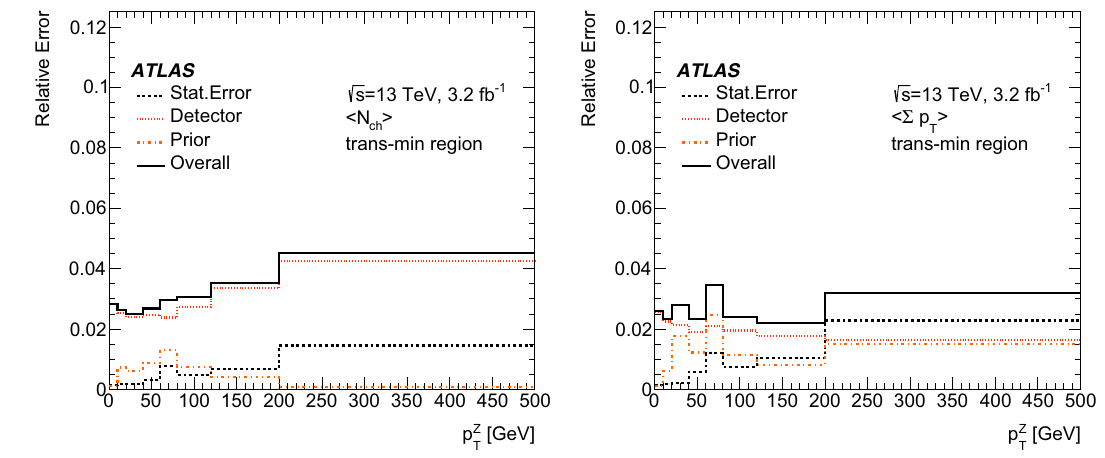
Fig. 3 A summary of the systematic uncertainties in the arithmetic mean of the N ch and (cid:8) p T spectra in the trans-min region as a function of p Z Here ‘Prior’ combines the two approaches to estimate the unfolding-related uncertainties. ‘Detector’ includes the modelling of the detector and the pile-up